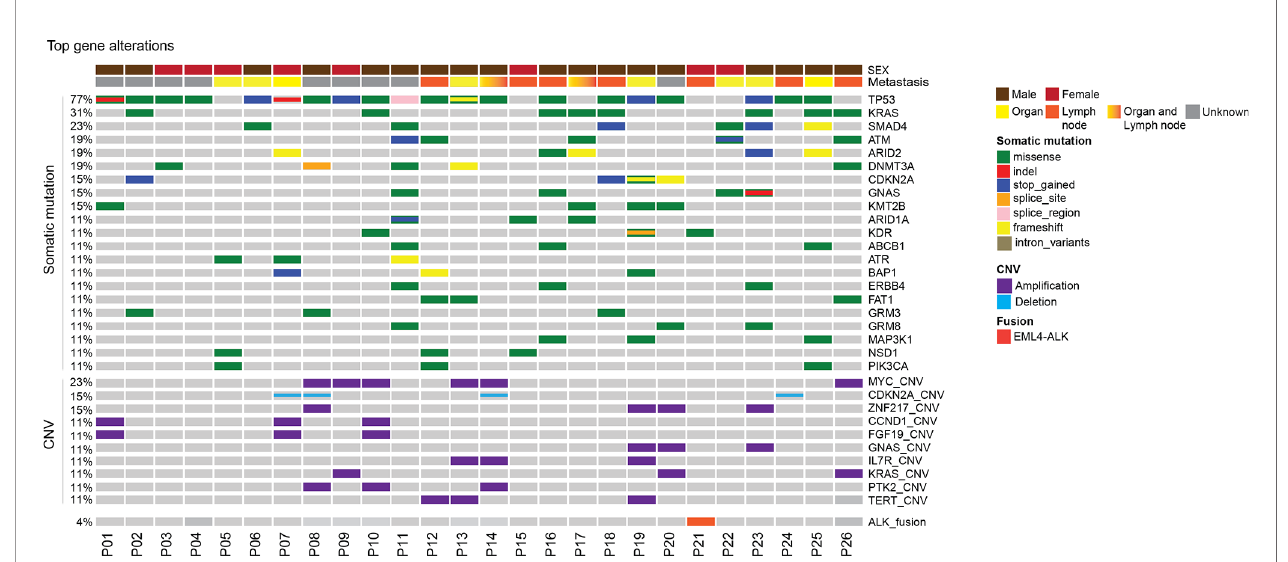
FIGURE 1 | Mutational landscape of patients with unknown primary tumor. Distribution of individual gene mutations and copy number variation, ALK fusion in the cohort as assessed by target panel sequencing. The sex of patients was provided as bars on the top. The mutation types were indicated by the color on the right. Each column represents one patient.